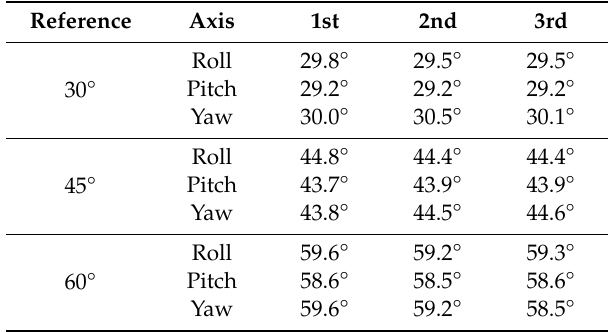
Table 1. Comparison of the Euler angles for each axis in the static condition.